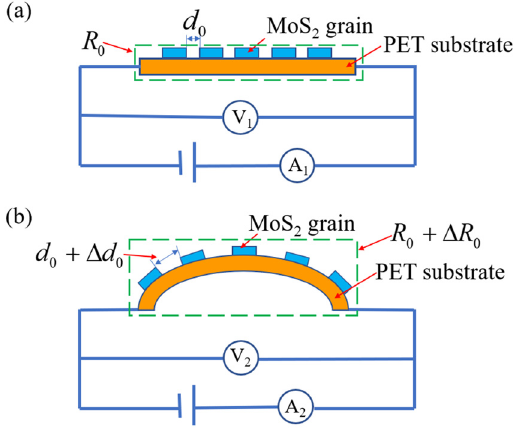
Figure 8: Schematics of measuring the current – voltage curves of MoS 2 fi lm/PET composite sensor at ( a ) relaxed state and ( b ) stressed state. d 0 and d 0 + Δ d 0 are the tunneling gap between MoS 2 fi lms at the relaxed and stressed states, respectively. R + 0 and R 0 Δ R fi lm/PET composite at relaxed 0 are the resistance of the MoS 2 and stressed states,